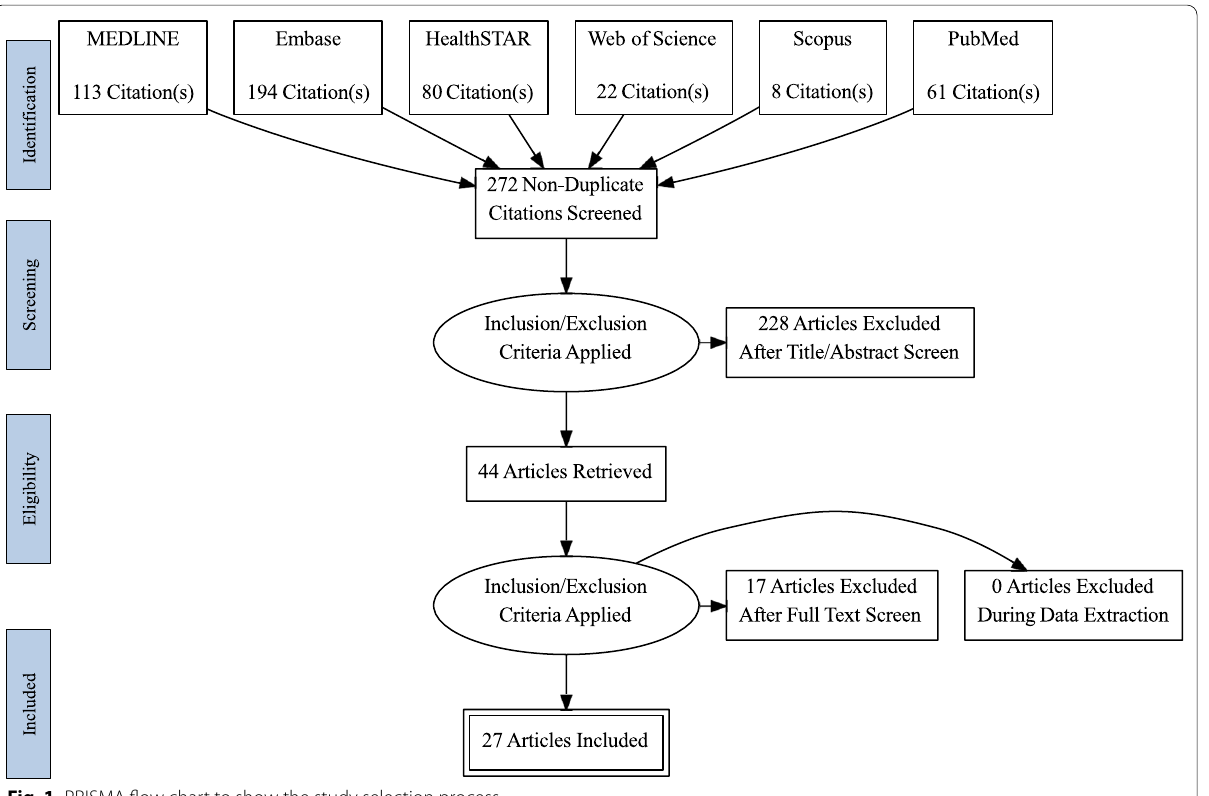
Fig. 1 PRISMA flow chart to show the study selection